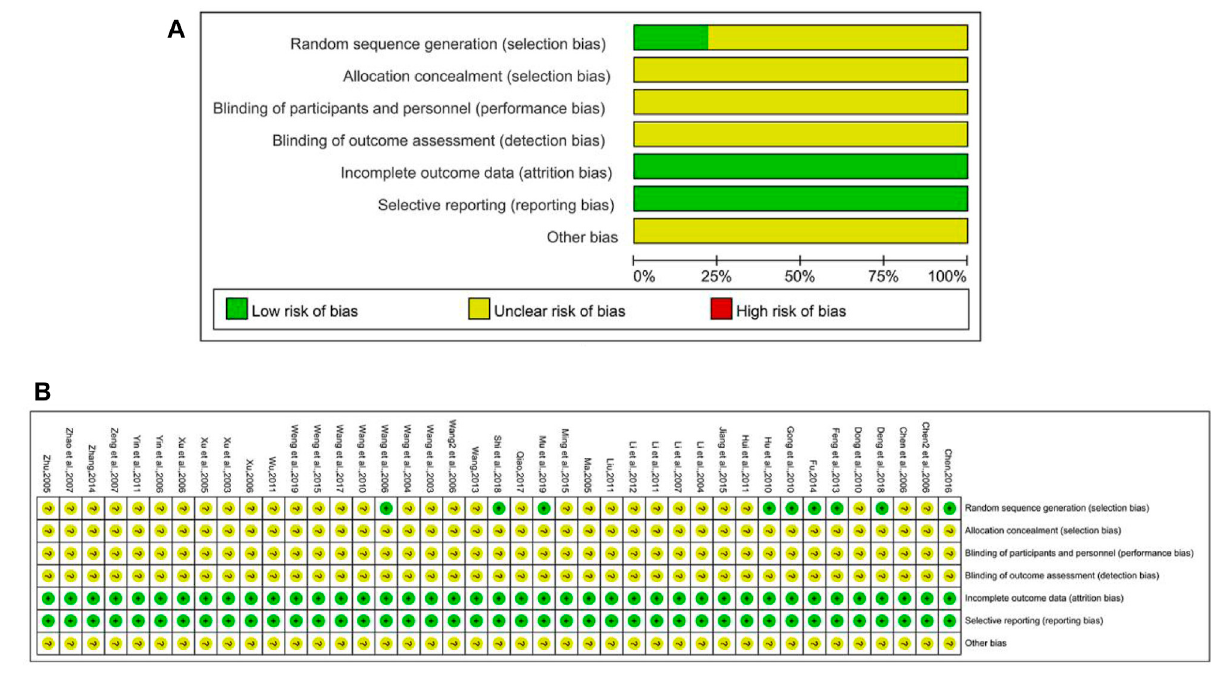
Frontiers in Pharmacology |